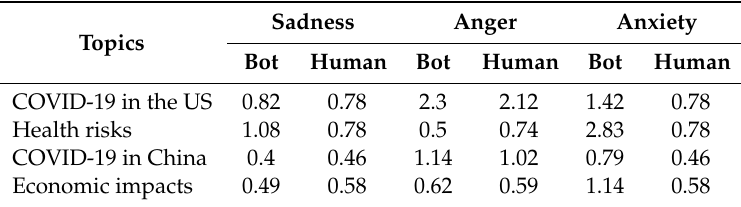
Table 3. Sadness, anger, and anxiety of social bots and humans for topics of which their overall sentiments polarity was negative.